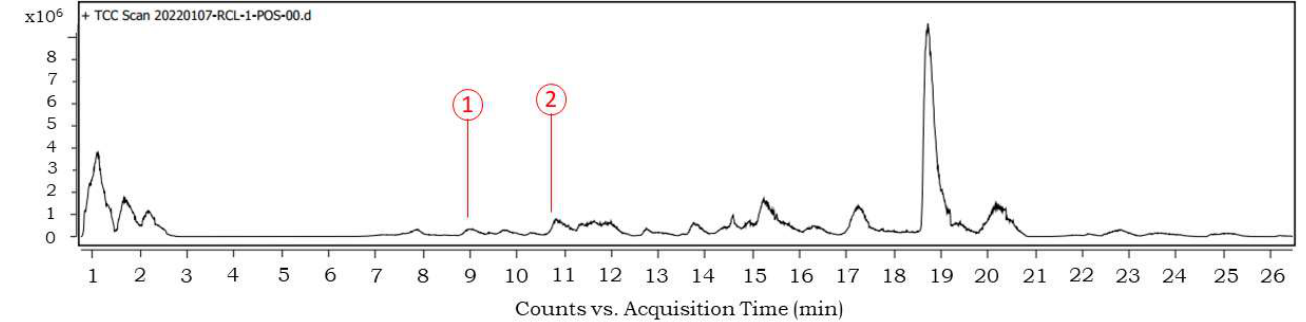
Figure 5. UPLC-UV-MS analysis on positive node for methanol extract with identified peaks of 1. Pseudopurpurin, 2. Morindaparvin A.